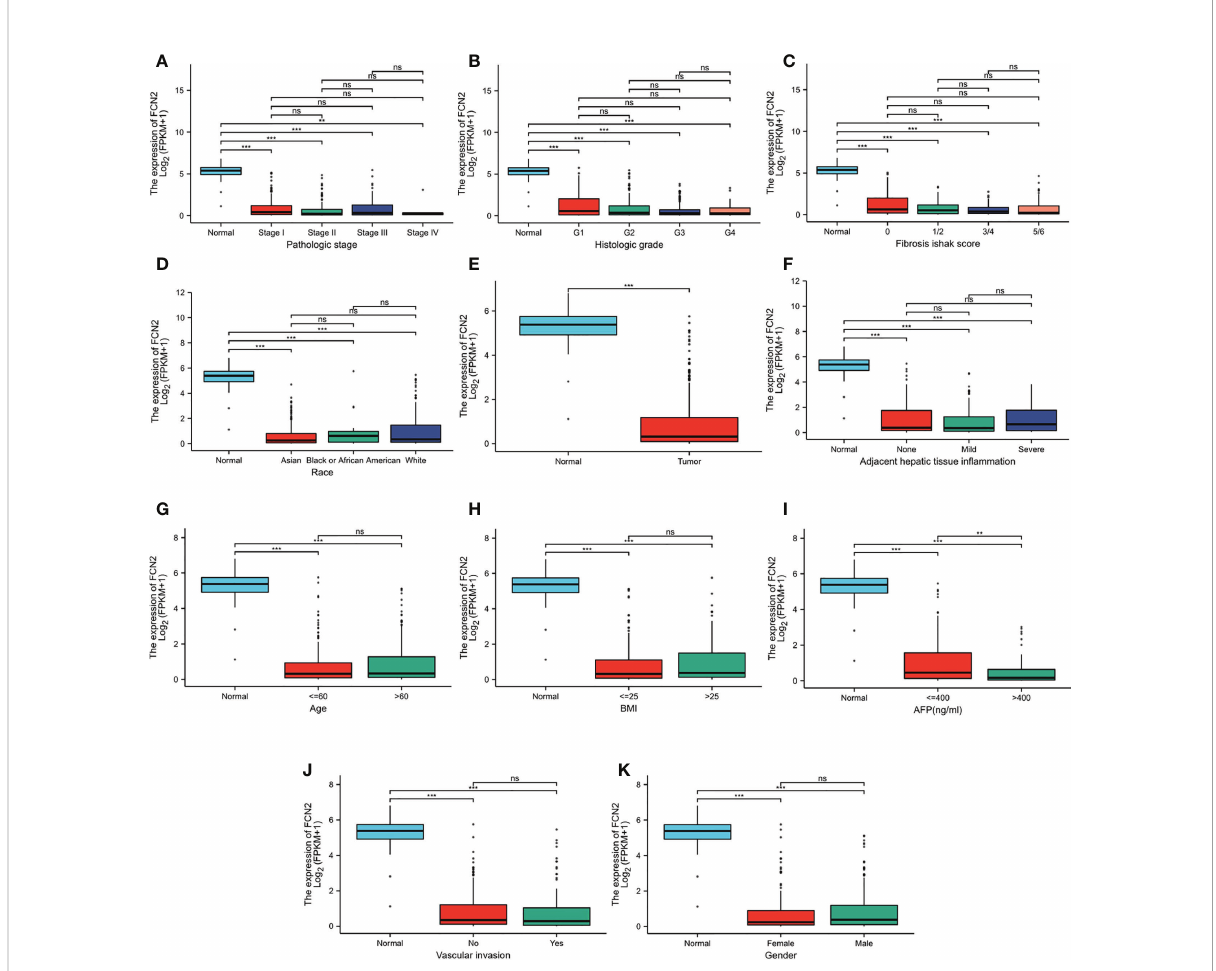
FIGURE 6 Different expressionlevelsof FCN2 inliverhepatocellularcarcinoma(LIHC)basedonTheCancerGenomeAtlas(TCGA)analyzedusingR. (A) Pathologic stages. (B) Histologicalgrade. (C) FibrosisIshakscale scores. (D) Race. (E) Normal tissueandlivercancer. (F) Adjacenthepatictissue in fl ammation. (G) Age (H) . BMI. (I) Alpha-fetoprotein (AFP). (J) Vascularinvasion. (K) Gender. * p <0.05, ** p <0.01, *** p < 0.001. ns:notstatisticallysigni fi